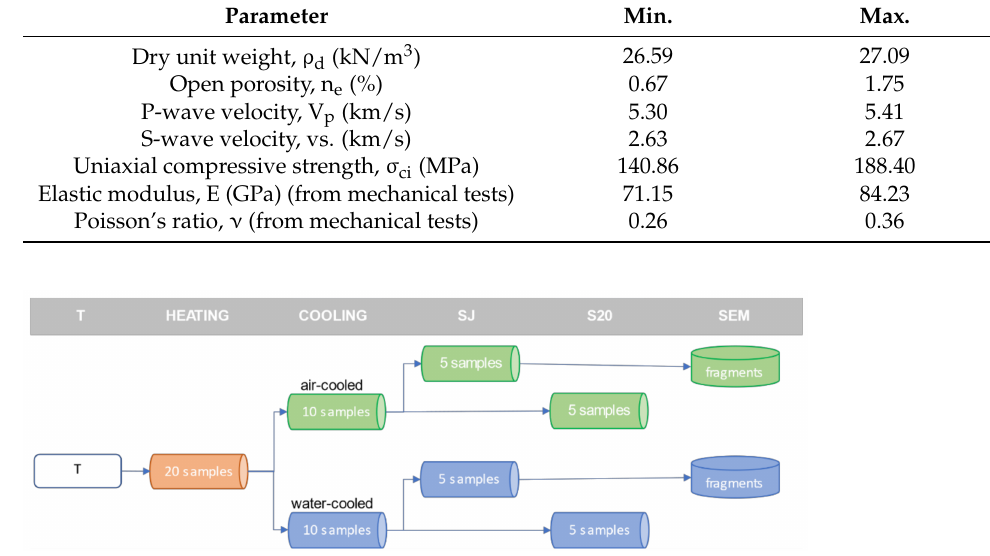
Figure 4. Methodological scheme of the laboratory tests and the number of samples tested. The tests performed at each temperature (T) are: Siever’s J drillability value (SJ); brittleness value (S 20 ); and microstructure by scanning electron microscopy